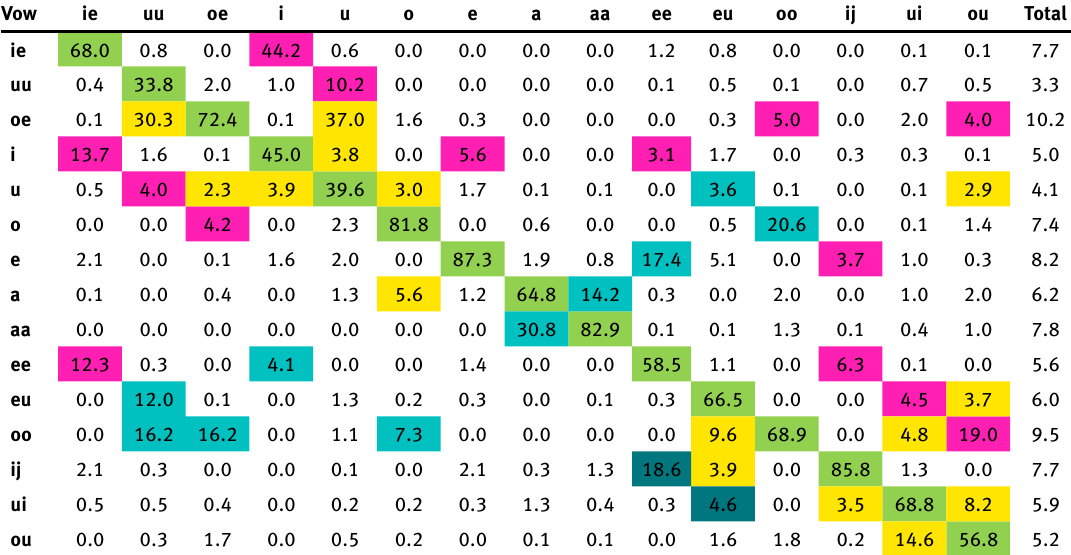
Table 9. Most frequent canonical (indicated in green) and non-canonical transcriptions of all 15 Dutch vowels produced by Spanish learners, as given by non-expert native Dutch listeners; target vowels in the columns, classified vowels in the rows, non-canonical transcriptions with deviations > 2.5% related to vowel height (in pink), vowel length (in turquoise), rounding (in yellow) and diphthongization (in teal) are also indicated; Vow = target